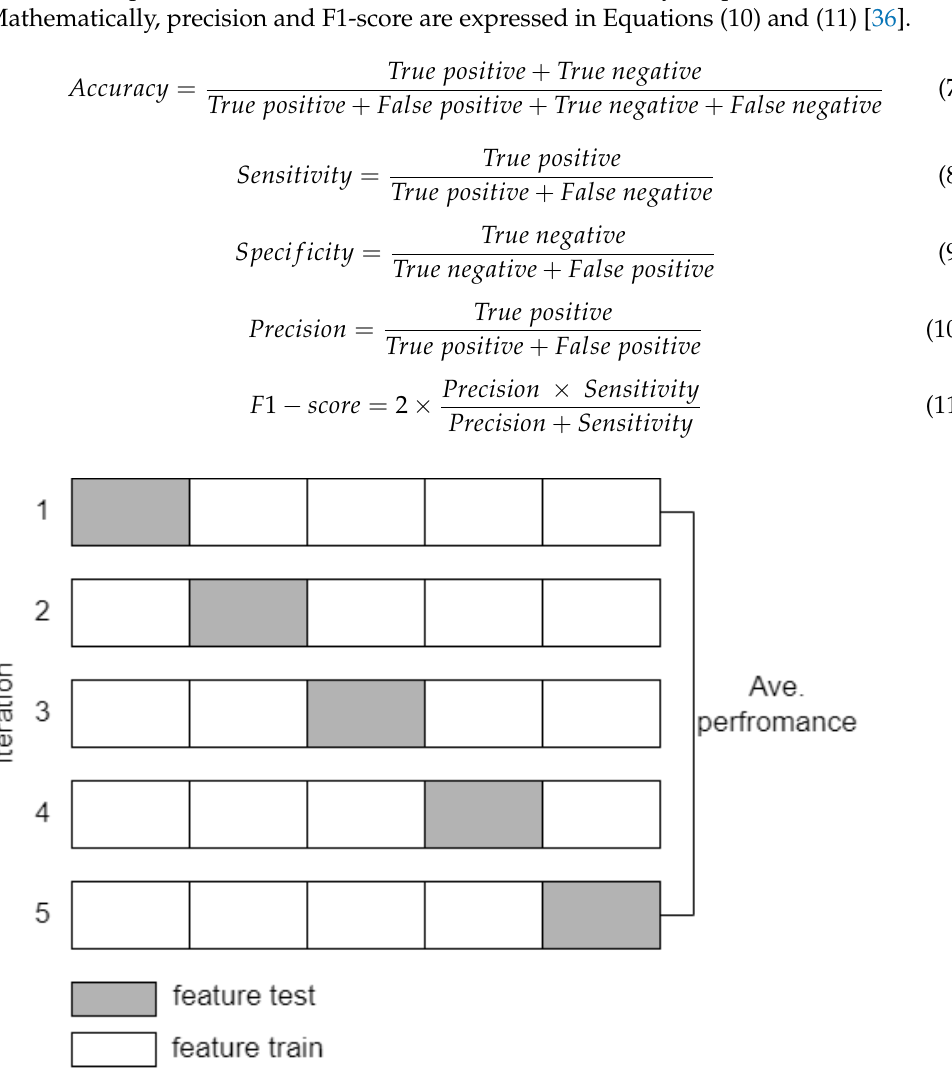
Figure 8. Cross validation scheme with k = 5.